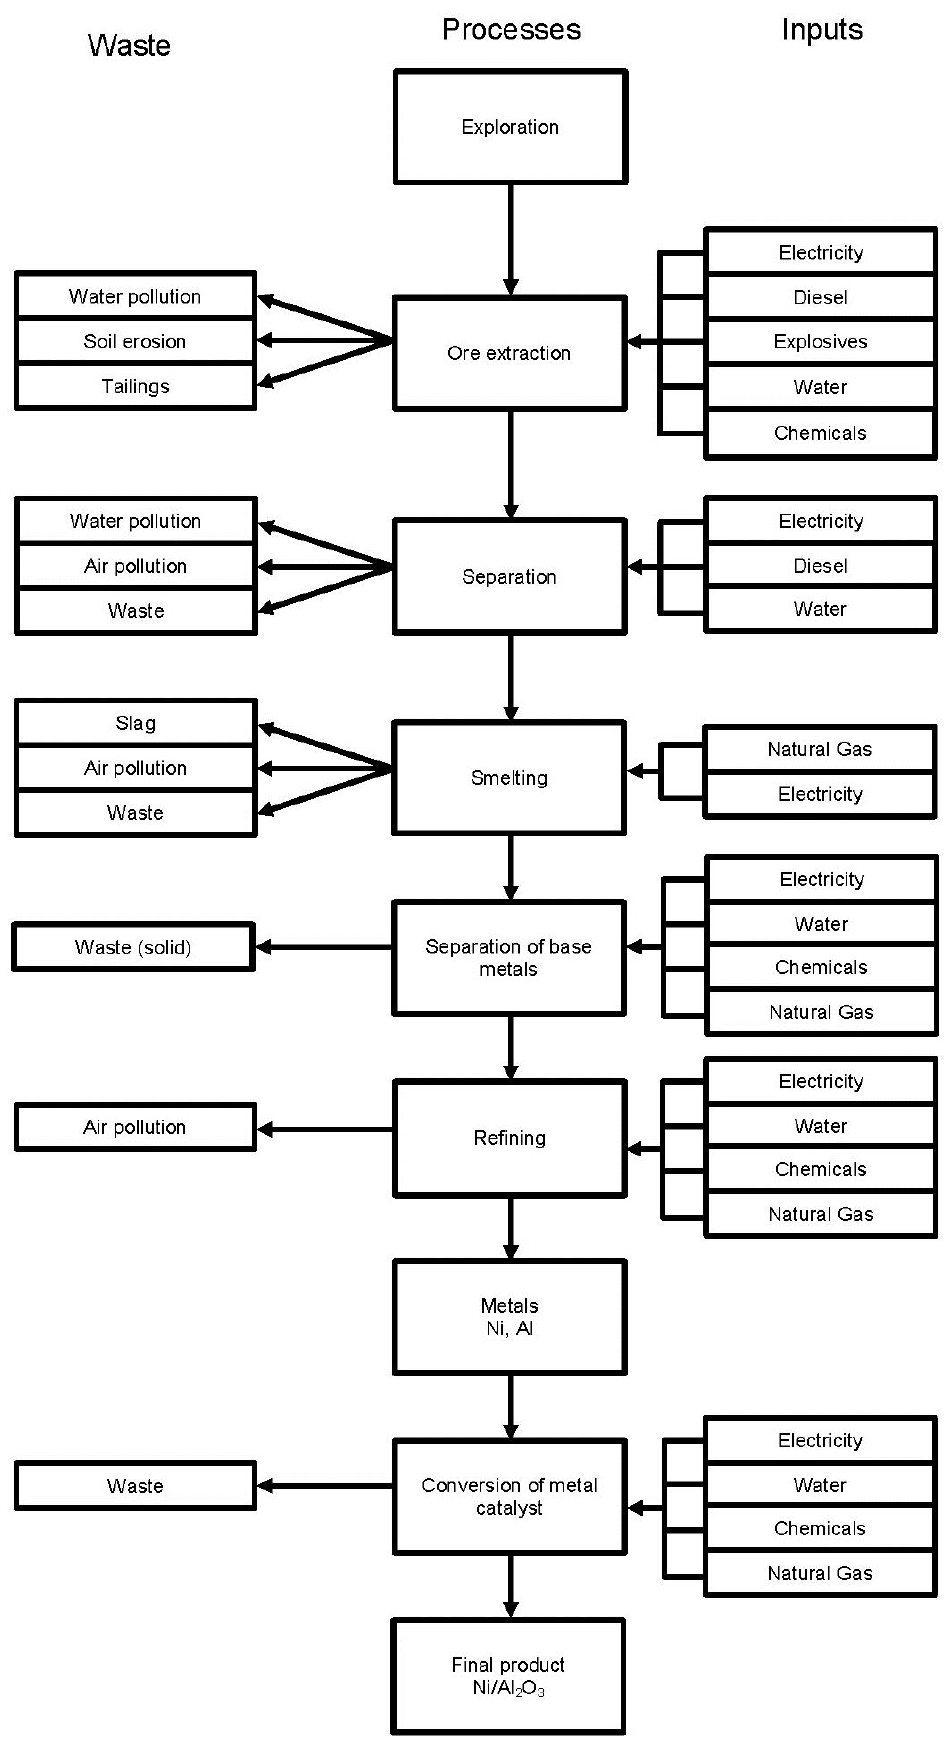
Figure 1. Simplified system boundary for metal catalyst